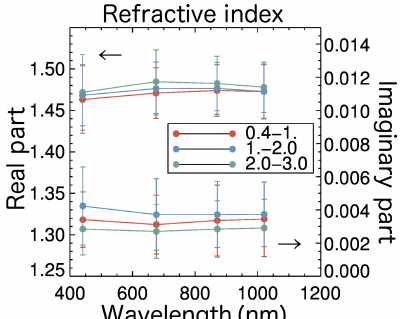
Figure 3. Size distribution as a function of AERONET AOD at 0.675µm, generated from the AERONET inversion products at the five sites in Indonesia during August to October 2015. There are 163 total retrievals used in this plot separated into bins of AOD. The number of retrievals within each AOD bin is shown in paren- theses in the label. The error bars represent the standard deviation within each size bin.